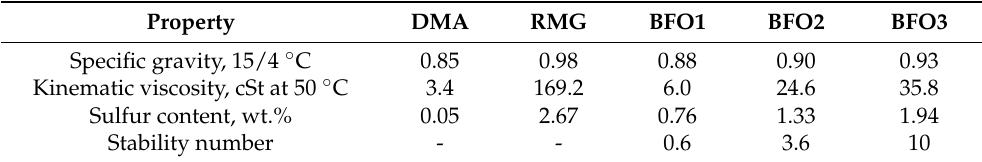
Table 2. Properties of feedstocks and blended fuel